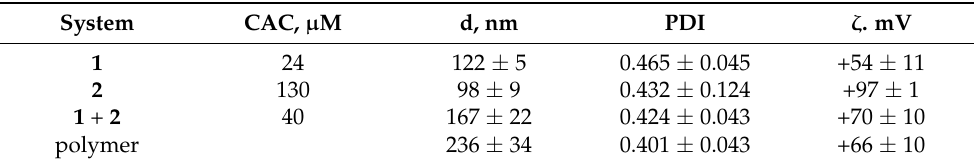
Table 1. CAC values, DLS, and ELS data of aggregates formed by macrocycles 1 , 2 and their mixture before and after CuAAC polymerization. System CAC, µ M d, nm